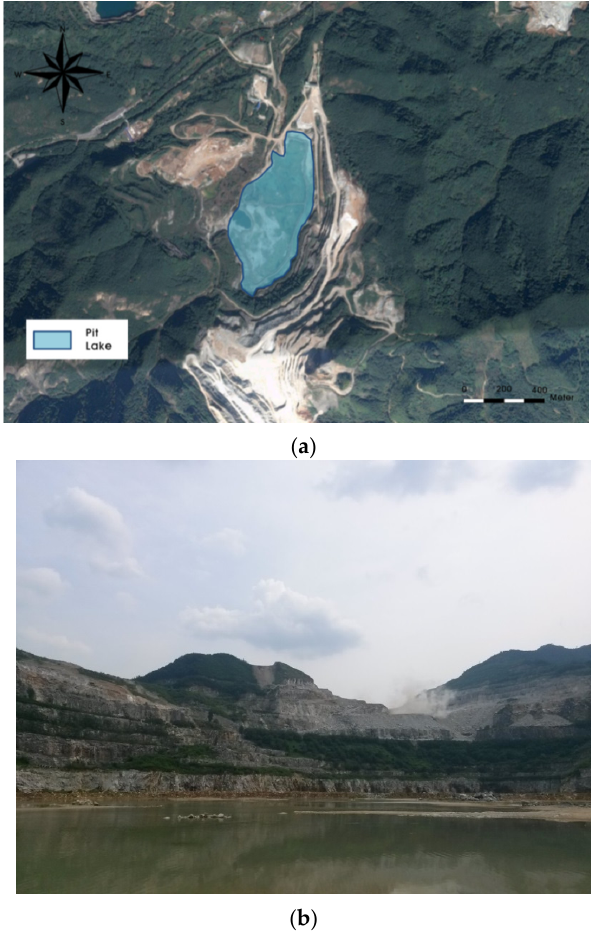
Figure 1. Study area: ( a ) Boundary of the pit lake planned in Pit 1; ( b ) View of the current pit lake naturally established in Pit 1. Table 1. Meteorological characteristics of the study site.